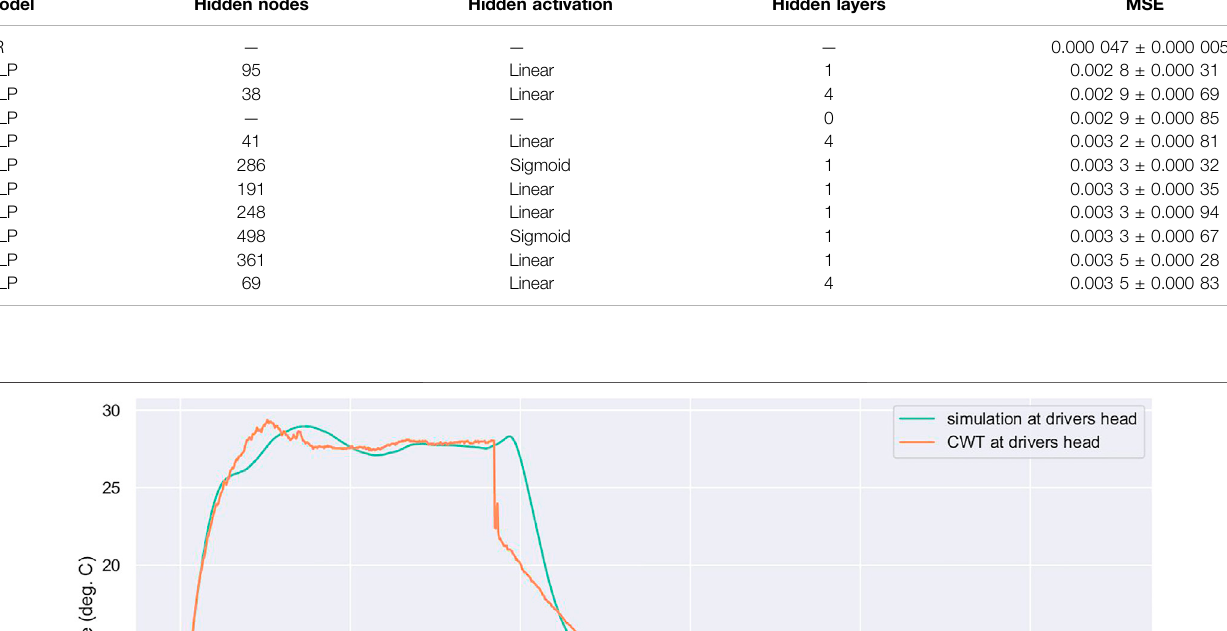
TABLE 4 | Linear regression and the top 10 MLP from the hyperparameter search results where the fi nal activation is linear and there is no dropout. Model Hidden nodes